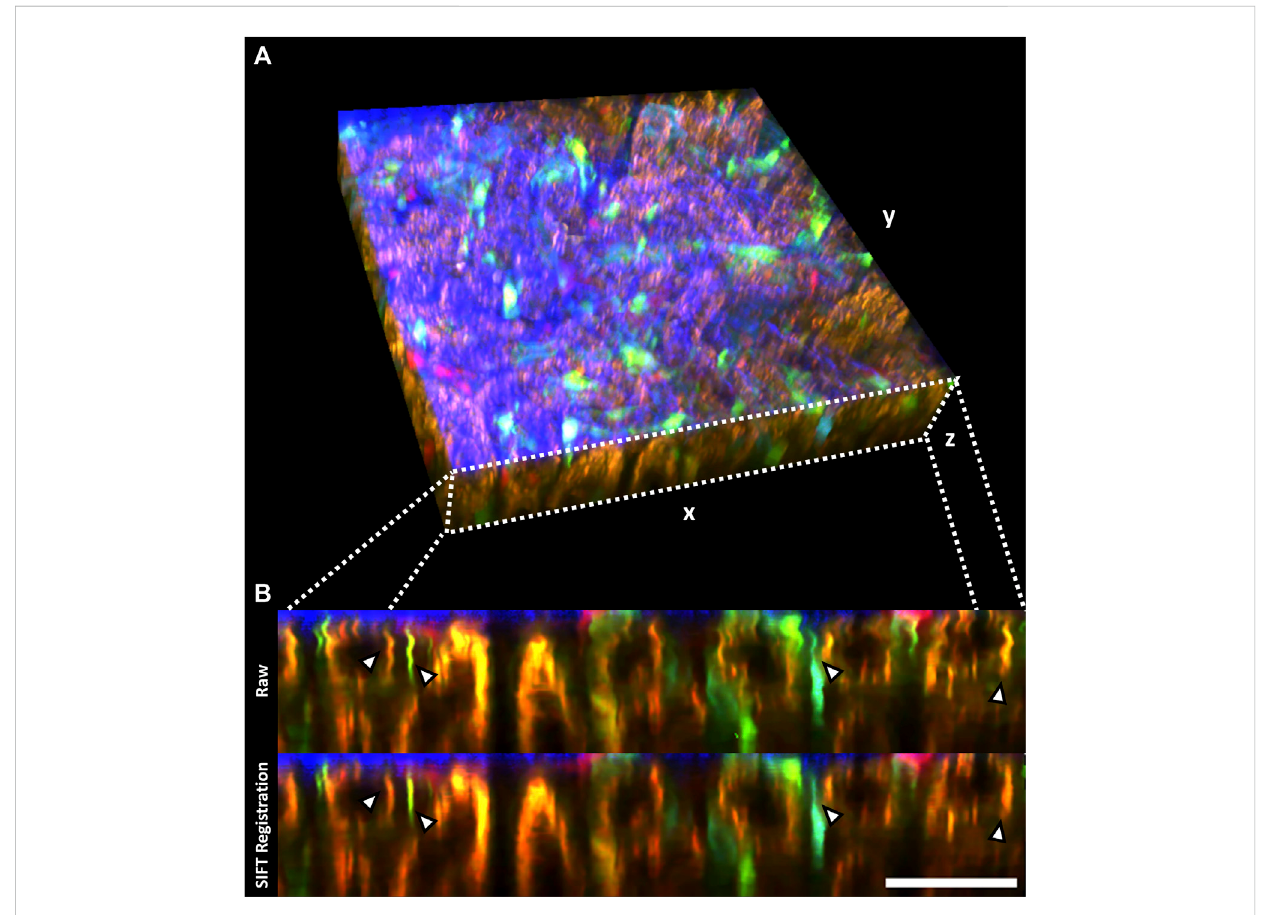
FIGURE 4 2D registration of volumetric data (Zstack) with SIFT minimizes sample drift-induced image artefacts. (A) Volumetric rendering of an intravital 2- photon microscopy Zstack acquired in a Cdh5-Confetti mouse. The renal capsule is visualized in blue through second harmonic signal. Endothelial cells expressing the Brainbow2.1 reporter system can be identi fi ed through 10 different color combinations (Table 1). (B) xz cross-section through the Zstack demonstrates image artefacts introduced by breathing movements in raw data (Raw, upper row). Thin fl uorescently labeled endothelial cells show warped, wave-like appearance in the axial cross-section (arrowheads). SIFT 2D registration largely reduces sample drift on volumetric data (lower row, arrowheads). Scale bar = 50